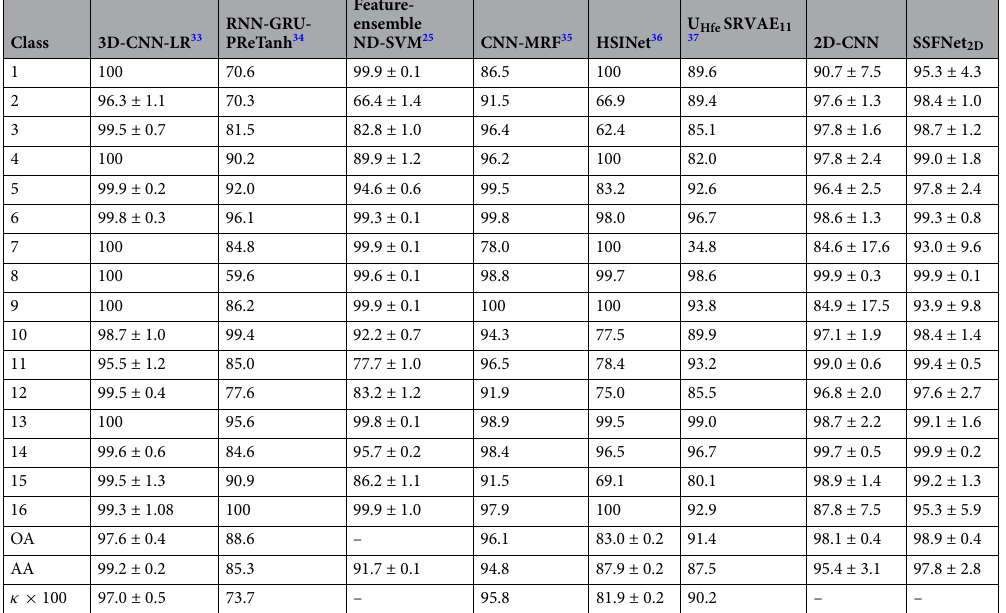
Table 3. Class-specific accuracies (%) on Indian Pines dataset.